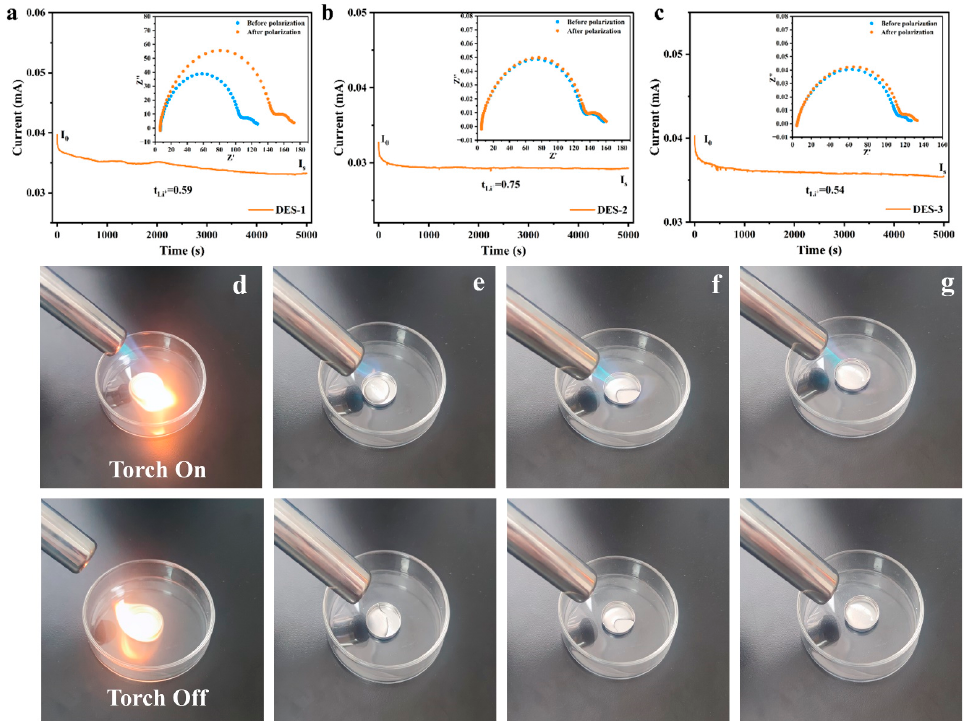
Figure 3. Current-time curve of Li||Li symmetrical cells with ( a ) DES-1, ( b ) DES-2, and ( c ) DES-3. The flame tests of ( d ) 1 M LiPF 6 EC/DEC, ( e ) DES-1, ( f ) DES-2, and ( g ) DES-3 with a torch turned on (up) and off (down).